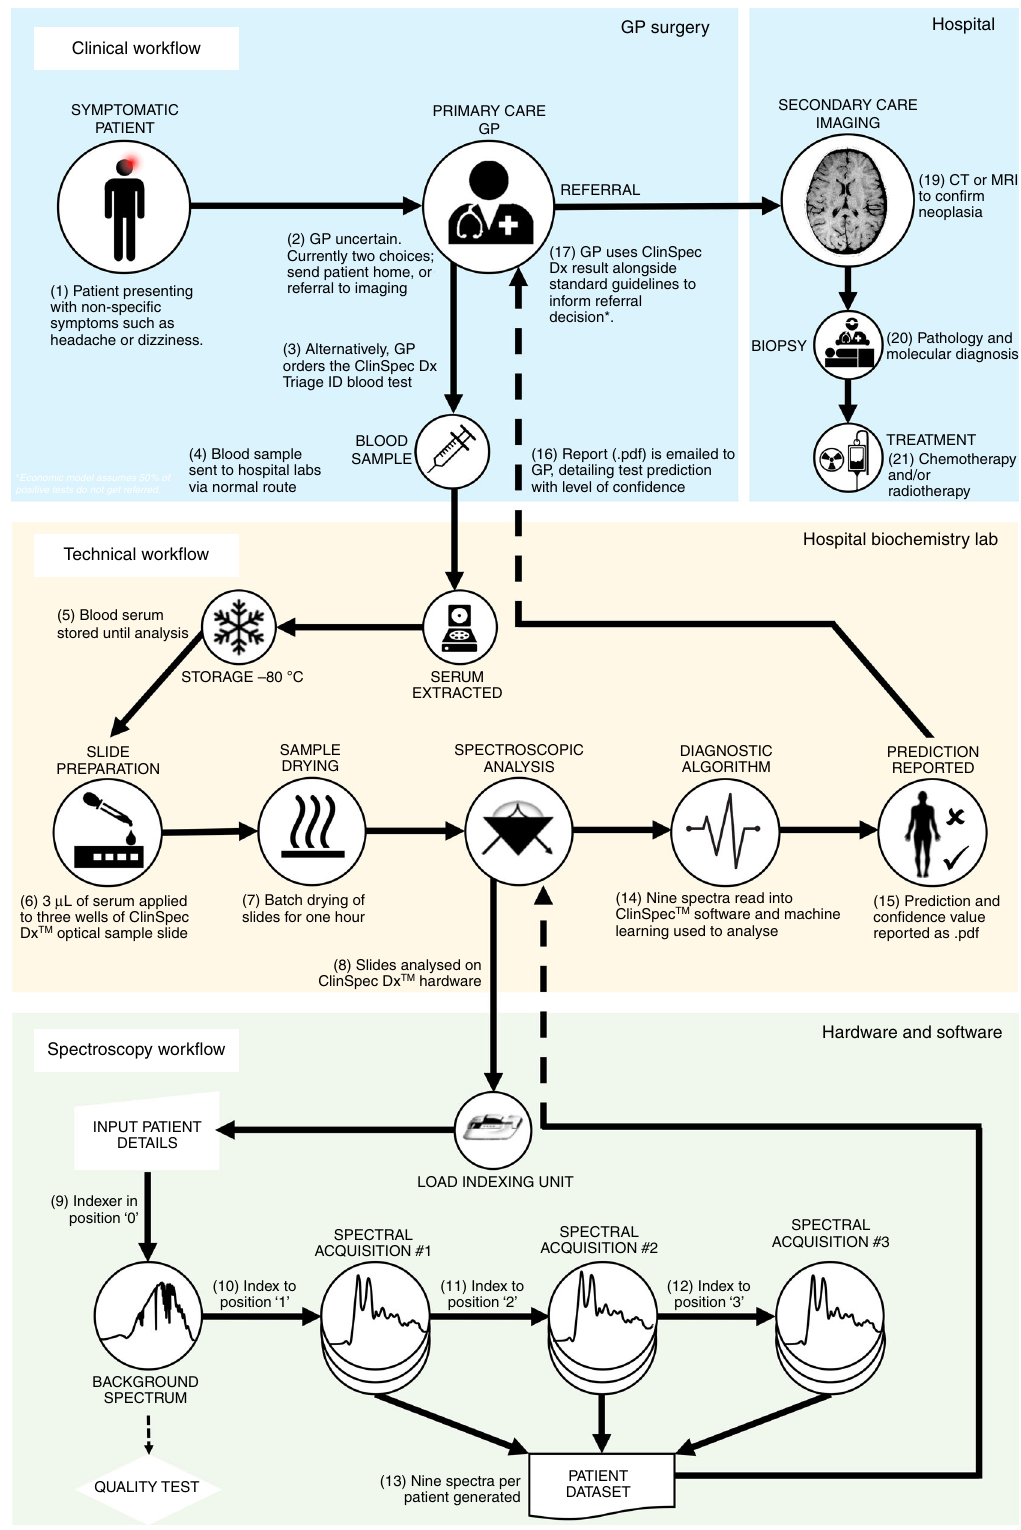
Fig. 1 Proposed integration of a blood test for the triage of brain cancer. Lack of speci fi c symptoms often results in brain cancer patients visiting their GPs numerous times before receiving a diagnosis; a blood test in primary care could effectively prioritise patients for urgent brain imaging, potentially reducing the time-to-diagnosis. The ATR-FTIR spectroscopy test would fi t into standard blood